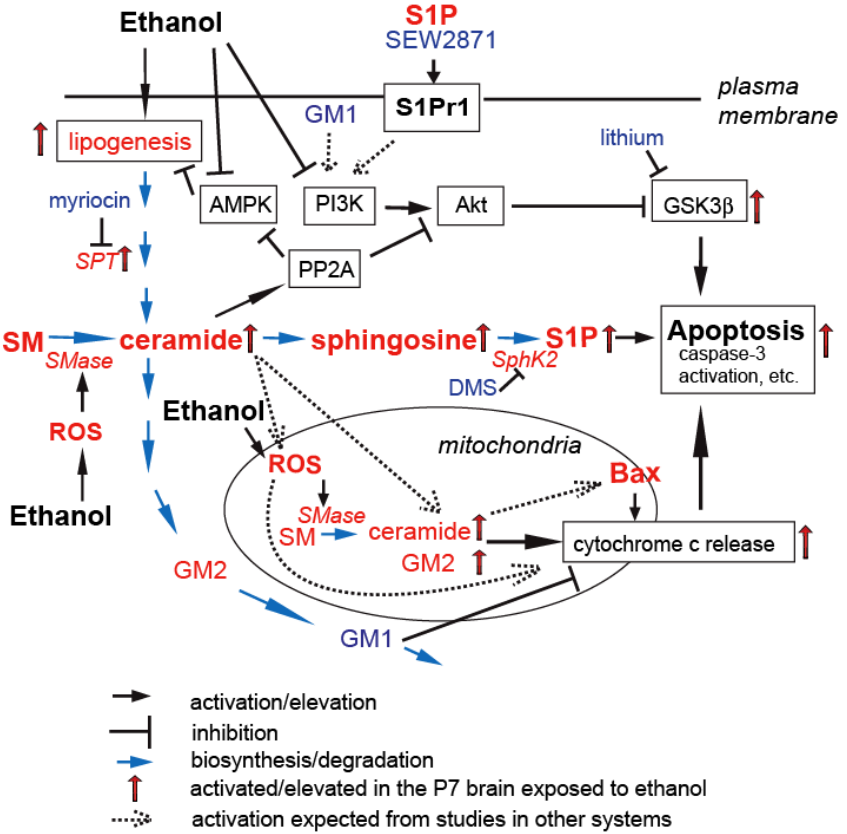
Figure 2. Sphingolipid involvement in ethanol-induced apoptosis in the P7 mouse